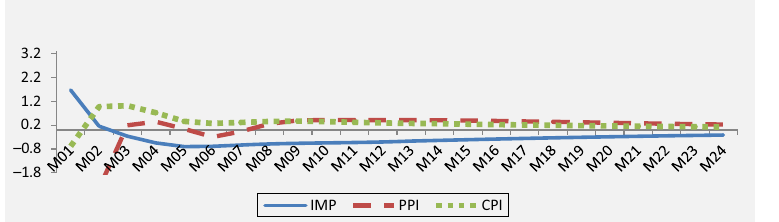
Figure 4. Dynamics of pass- through